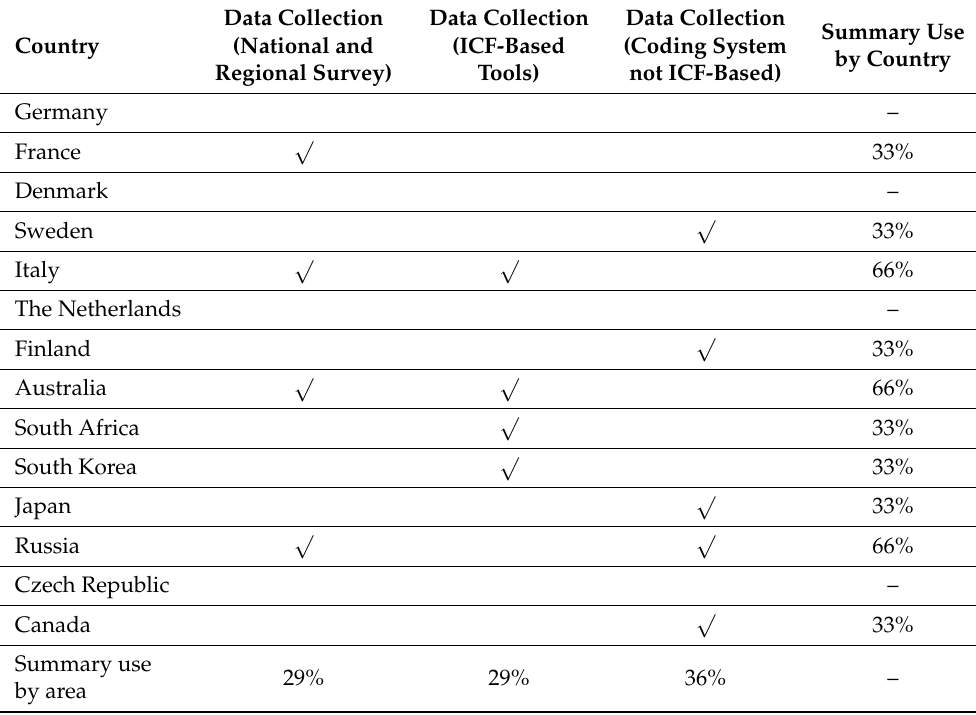
Table 4. ICF application in statistical